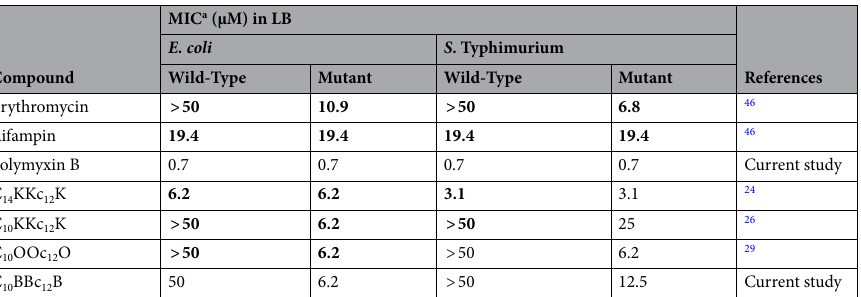
Table 2. Effect of RND pumps on growth-inhibitory activity. a Minimal inhibitory concentrations determined using the broth microdilution method, as respectively assessed against wild-type (Ag100 and 14028) and efflux deficient (Ag100a and 14028Δ AcrAB ) isogenic strains of E. coli and S . Typhimurium. Published data appear in bold fonts.